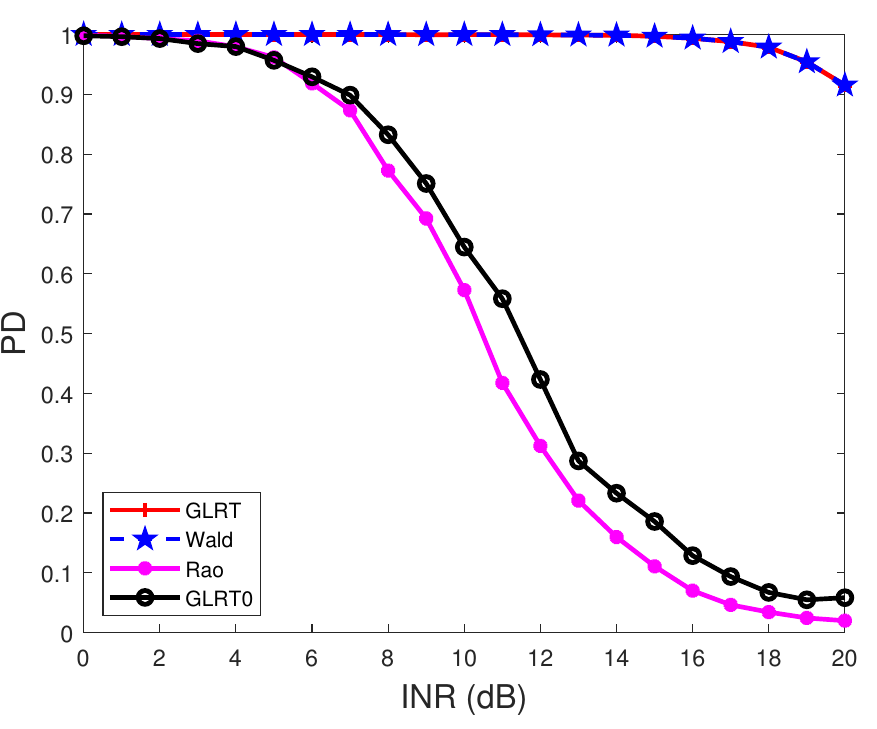
Figure 4. PDs of the detectors under different INRs. R ( i 1 , i 2 ) = 0.95 | i 1 − i 2 | , N = 8, p = 1, M = 2 N , θ t = 0.2, θ 1 = 0.25, θ 2 = − 0.2, θ 3 = 0.4, and SNR = 15 dB.